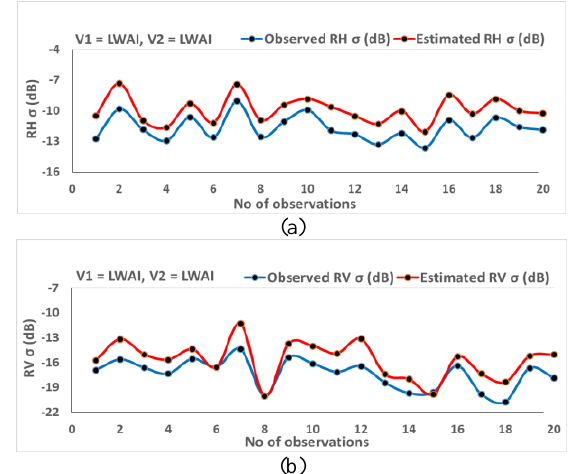
Figure 5. Observed v/s Estimated (a) RH and (b) RV backscatter for Model III